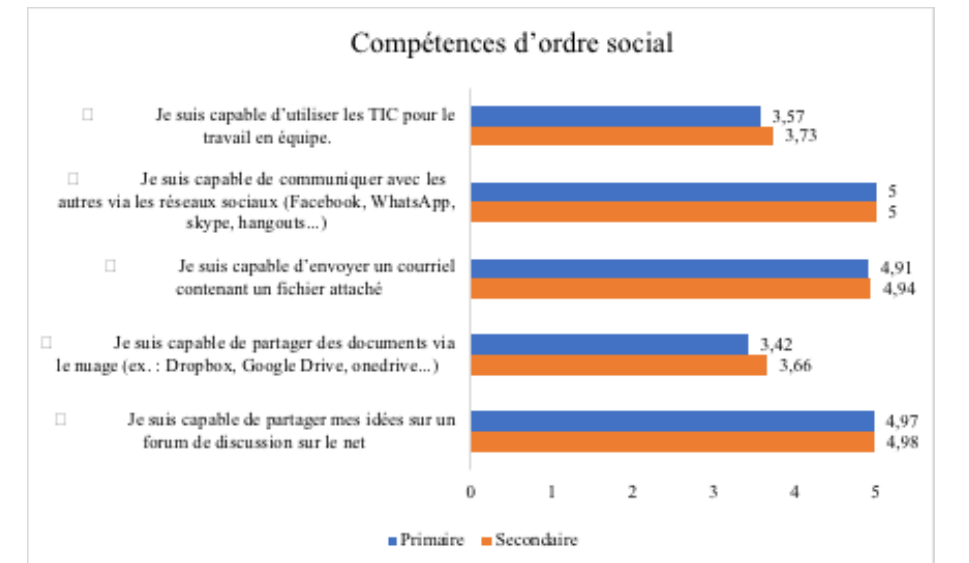
Fig. 6. Représentations sur le degré de maîtrise des compétences numériques techniques.